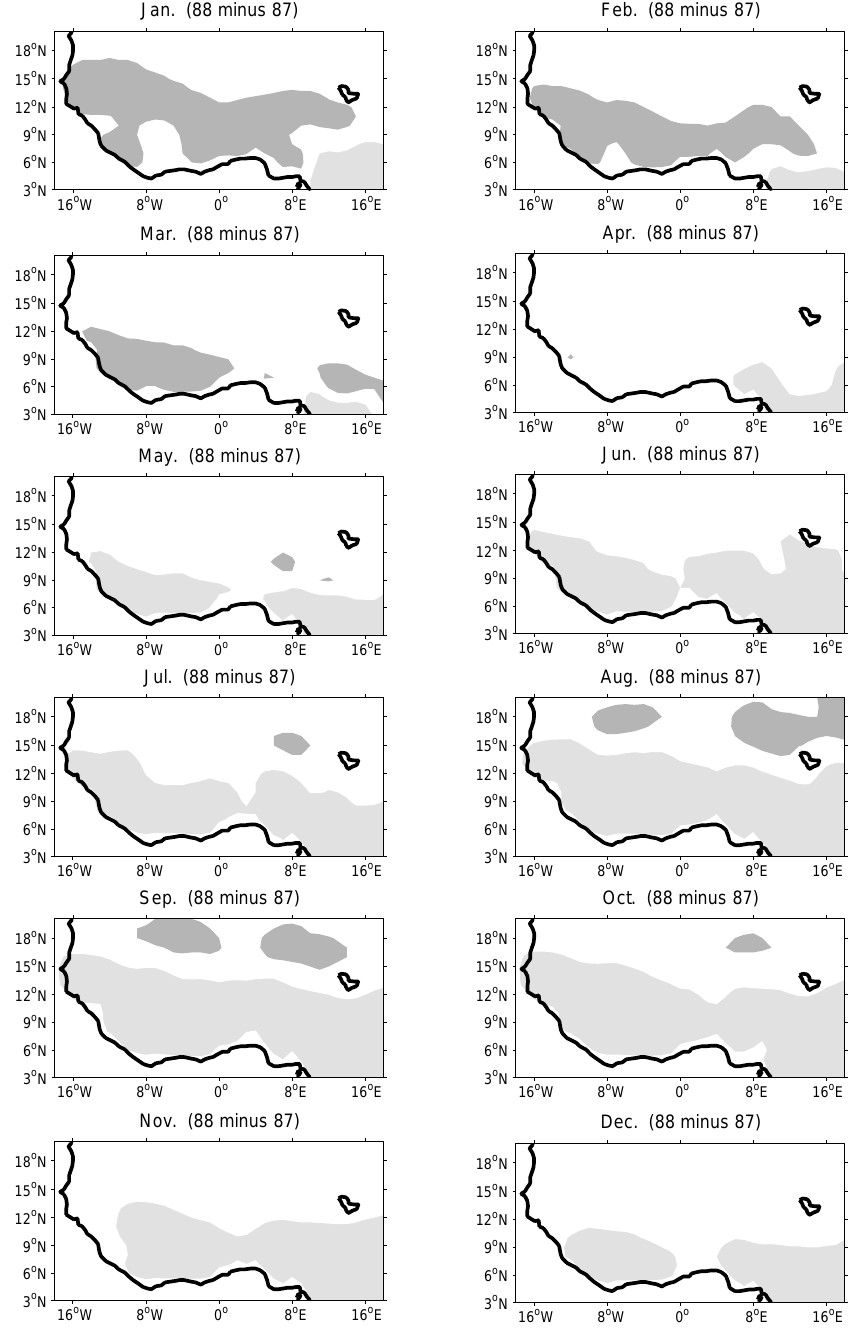
Fig. 6. 1988 minus 1987 maps of monthly deep soil wetness. Positive (negative) differences exceeding an absolute value of 0.1cm are displayed in dark (light) shading, these values ranging from − 0.59 to 0.38cm. Data source: